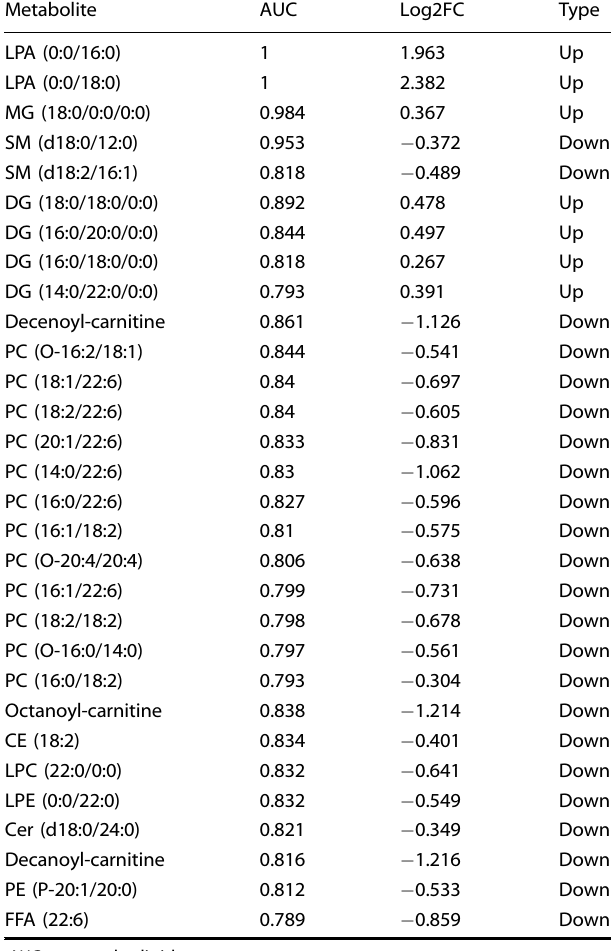
Table 2. Statistics of 30 lipid metabolites distinguish TB0 from HC Metabolite AUC Log2FC